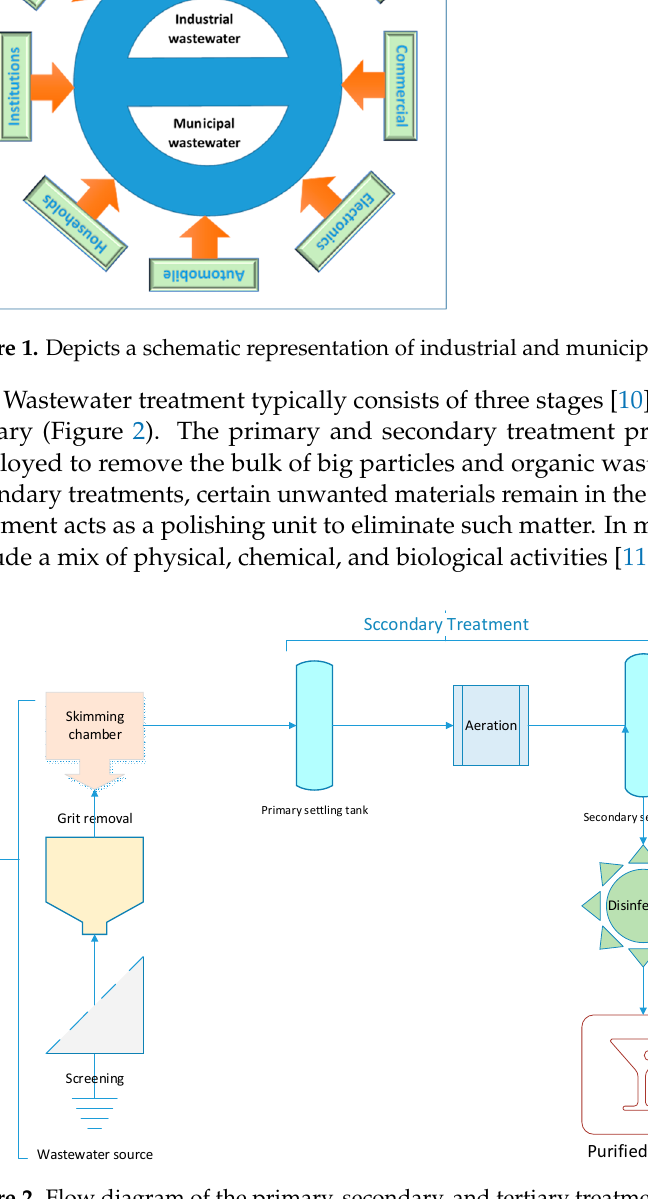
Figure 2. Flow diagram of the primary, secondary, and tertiary treatment processes